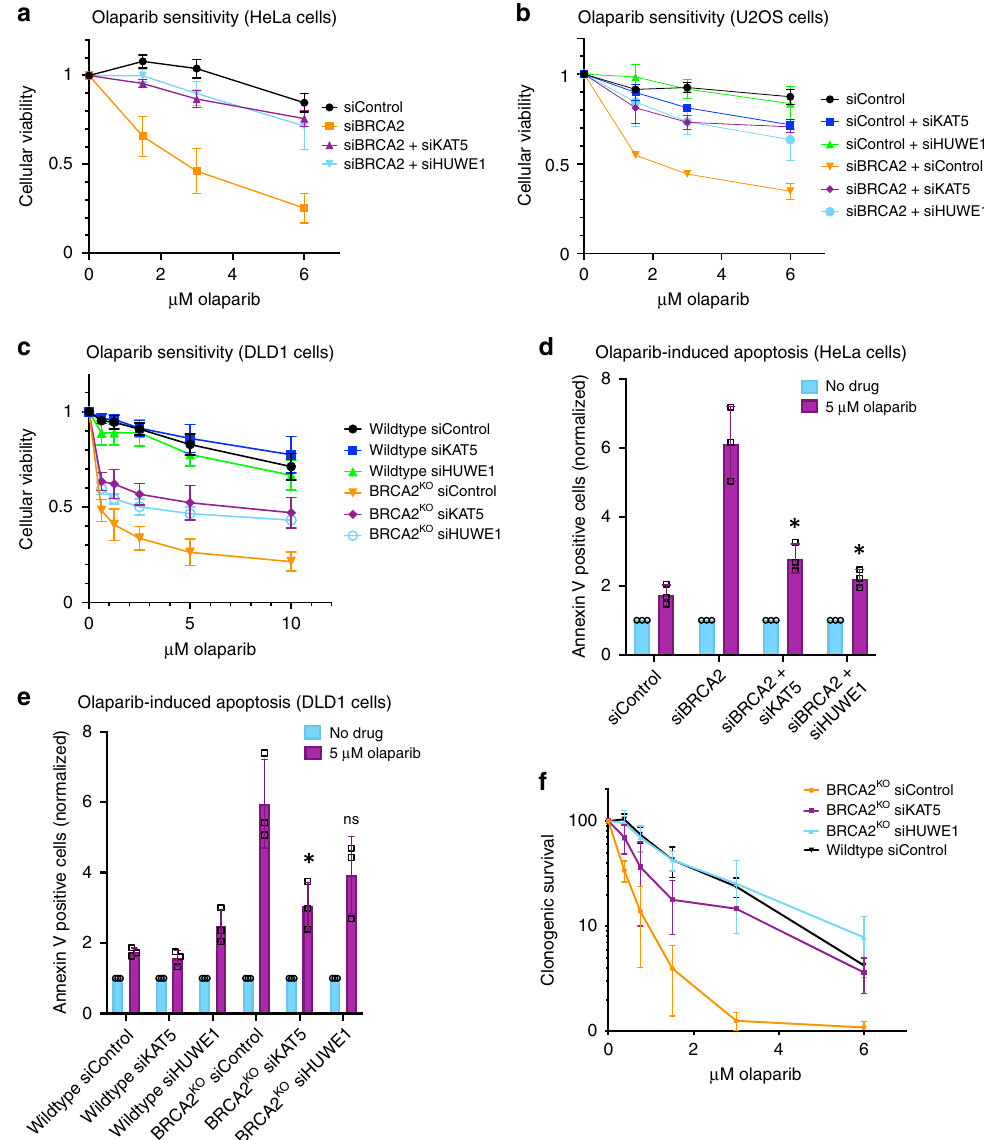
Fig. 3 KAT5 or HUWE1 knockdown in BRCA2-depleted cells results in PARPi resistance. a – c Knockdown of KAT5 or HUWE1 rescues the olaparib sensitivity of BRCA2-knockdown HeLa ( a ), BRCA2-knockdown U2OS ( b ), and BRCA2-knockout DLD1 ( c ) cells in cellular viability assays. d , e Olaparib- induced apoptosis is rescued by KAT5 or HUWE1 depletion in BRCA2-knockdown HeLa ( d ) and BRCA2-knockout DLD1 ( e ) cells. Asterisks indicate statistical signi fi cance ( t -test, two-tailed, unequal variance), compared to siBRCA2 ( d ) or BRCA2 KO siControl ( e ) samples. f KAT5 or HUWE1 depletion rescues sensitivity of BRCA2-knockout HeLa cells to PARPi in a clonogenic survival assay. All graphs re fl ect the average of three experiments performed after 72 h of treatment, with standard deviations shown as error bars. Source data are provided as a Source Data fi